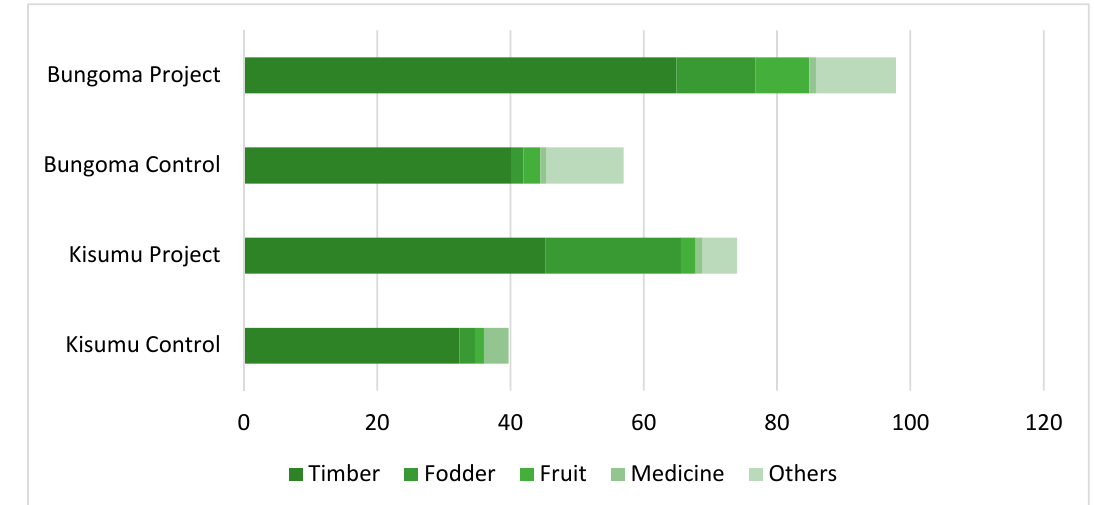
Figure 4. The average number of trees per farm on project and control farms in 2012, divided between fodder, fruit, medicine, timber and other tree types. In total, 65% of all trees were 10 cm or less in diameter at breast height, meaning that they were probably planted within the project period (since 2009). Eucalyptus comprised 4.6% of trees on control farms and 2.7% on project farms. Data from a tree survey in Kisumu (n = 37 control farms, n = 90 project farms) and Bungoma (n = 38 control farms, n = 60 project farms).